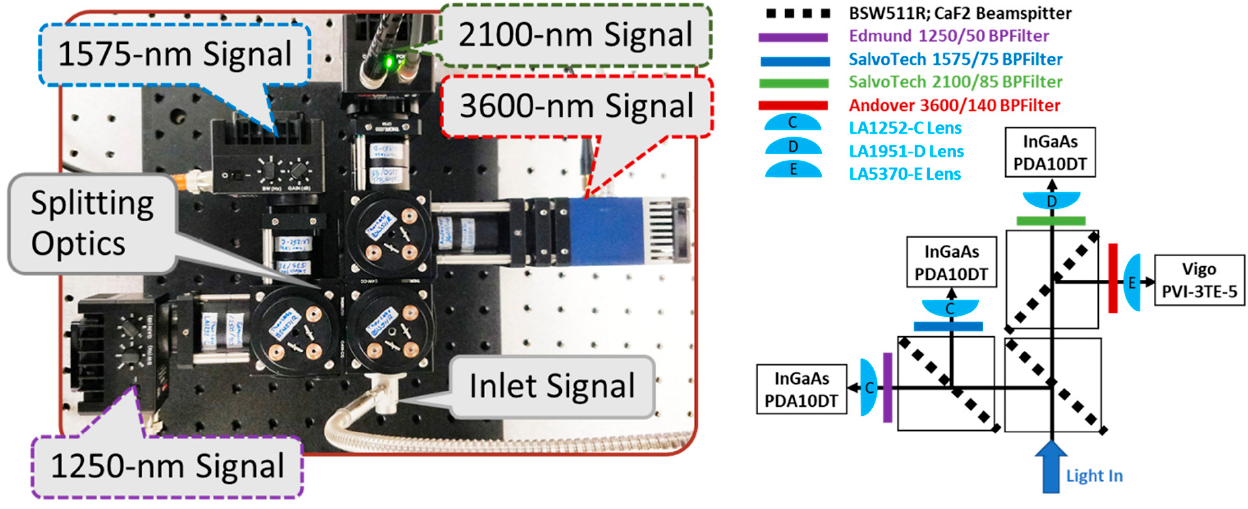
Figure 5. Pyrometry instrument setup picture and schematic detailing part